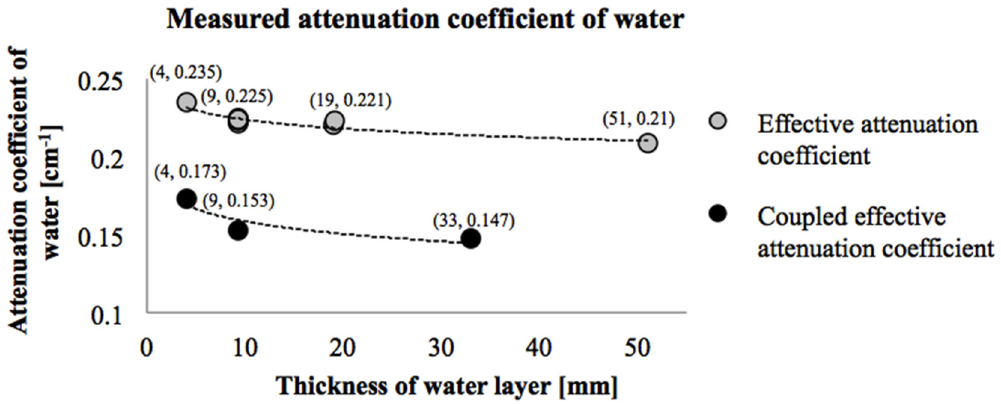
Figure 6. Influence of water layer thickness and parent material (mortar substrate) on measured attenuation coefficient of water.